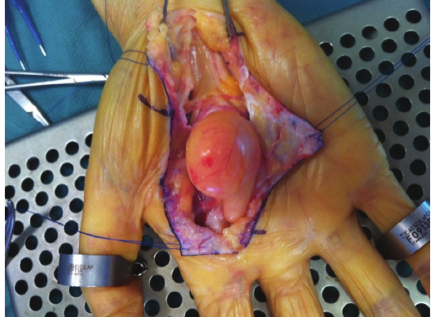
Figure 5: Peroperating view showing lipoma with fat aspect and well-defined